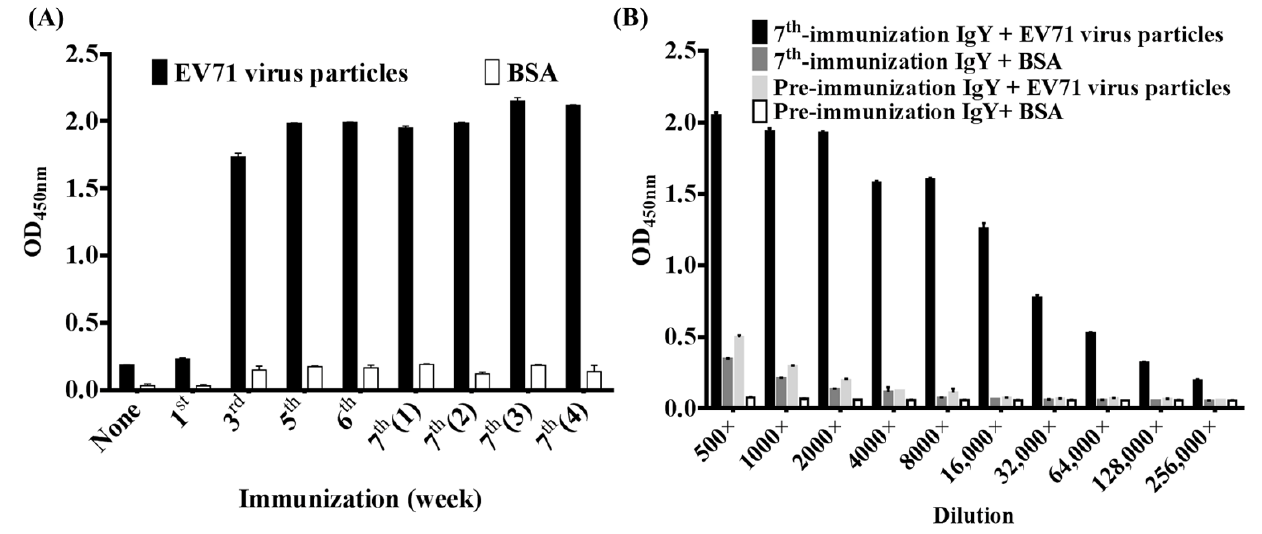
Figure 1. Humoral immune response in chicken. ( A ) The EV71 virus particles and BSA were immobilized on ELISA wells. Purified IgY from pre-immunization and each immunization were used to monitor the humoral immune response in chicken from the pre-immunized (None) to the fourth week after the 7th immunization (7th(4)). ( B ) Purified IgY antibodies from pre-immunization and the 7th immunization were in a series of two-fold dilutions (500 × to 256,000 × ) to test the binding abilities to EV71 virus particles and BSA, respectively. ELISA experiments were performed in a duplicated manner and statistically analyzed as mean ± standard deviation (SD).